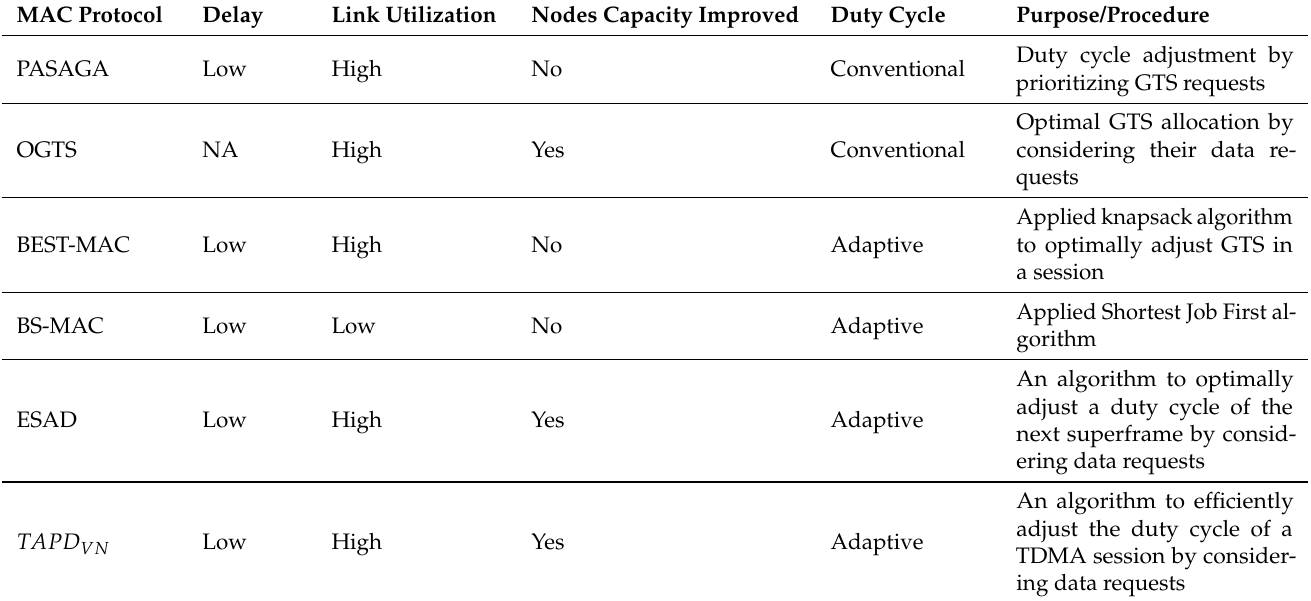
Table 1. Comparative table between different MAC.